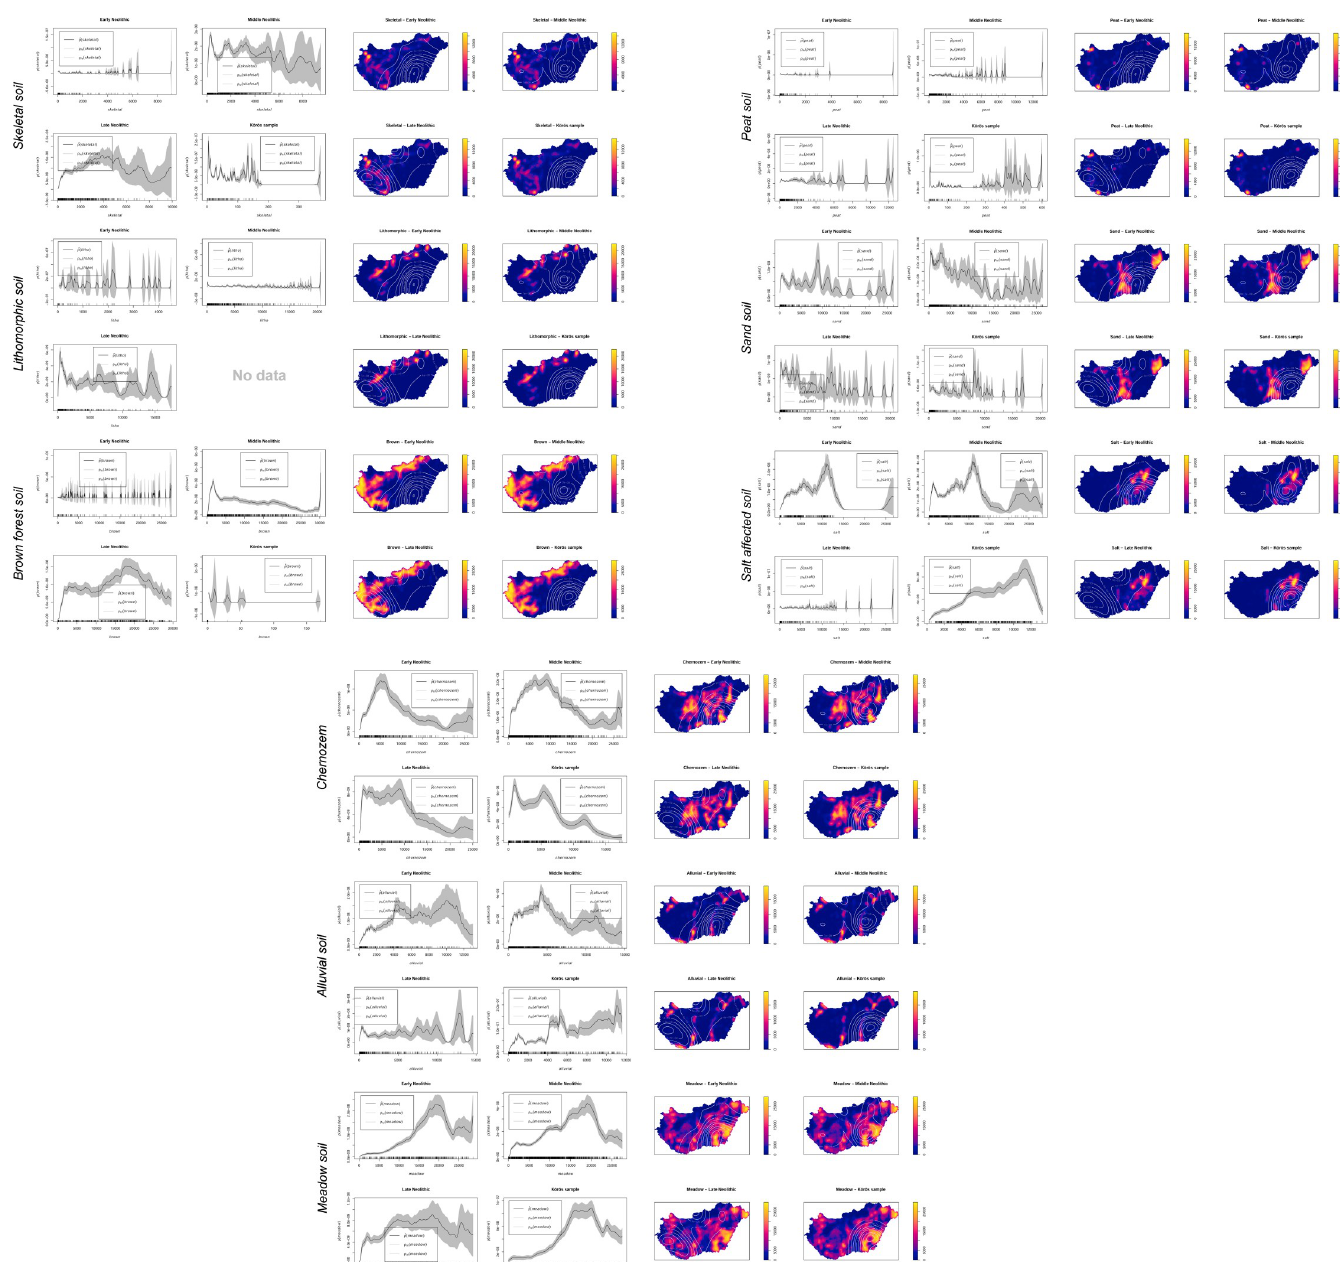
Fig 8. a. Rhohat plots of the point intensity as a function of the soil explanatory covariate (skeletal, lithomorphic, and brown forest soil). Each soil focal raster was plotted with the kernel density estimation contours to facilitate the interpretation of the plots. b. Rhohat plots of the point intensity as a function of the soil explanatory covariate (peat, sand, and salt affected soil). Each soil focal raster was plotted with the kernel density estimation contours to facilitate the interpretation of the plots. c. Rhohat plots of the point intensity as a function of the soil explanatory covariate (Chernozem, alluvial, and meadow soil). Each soil focal raster was plotted with the kernel density estimation contours to facilitate the interpretation of the plots.